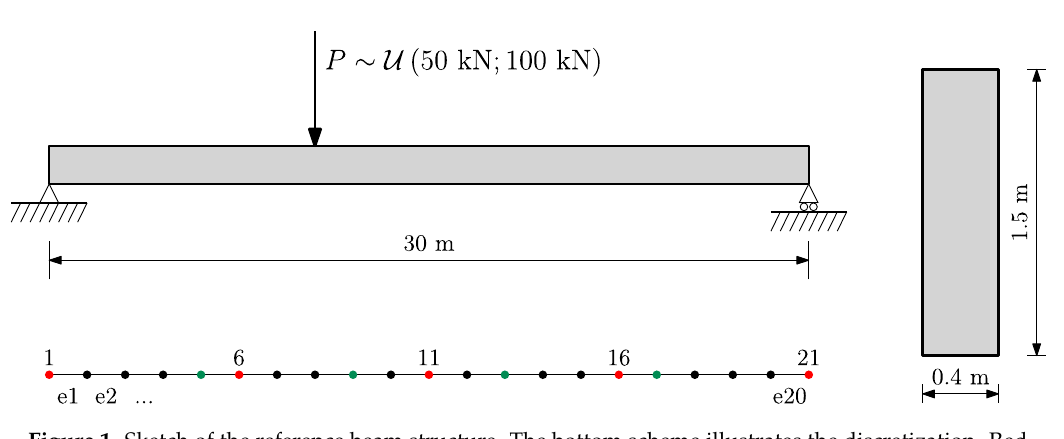
Figure 1. Sketch of the reference beam structure. The bottom scheme illustrates the discretization. Red nodes refer to the location of the inclinometers; green nodes refer to the location of the load P in the third simulations subset (Subset C).